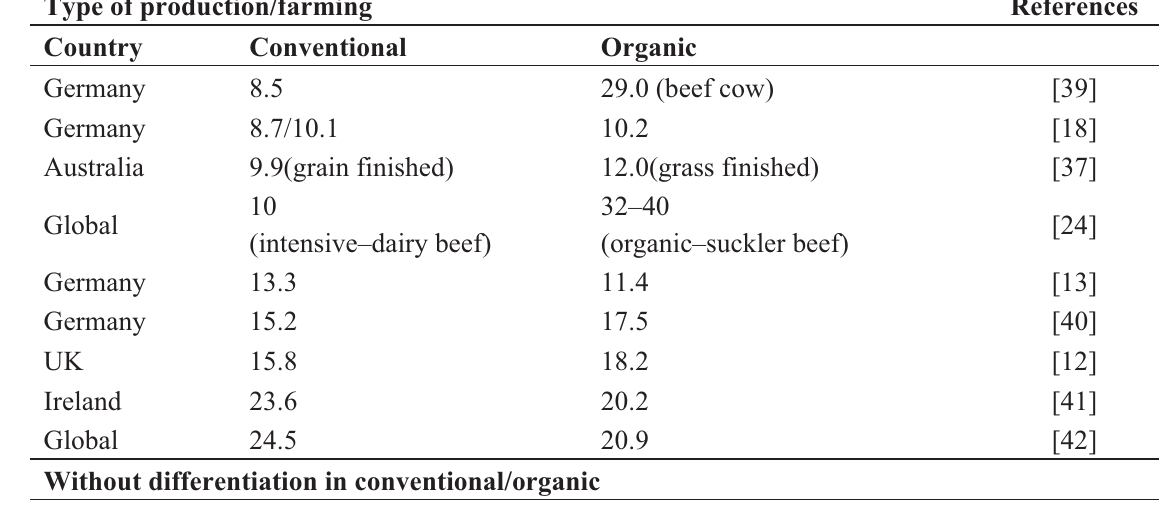
/kg carcass weight gain) of beef cattle depending on 2eq